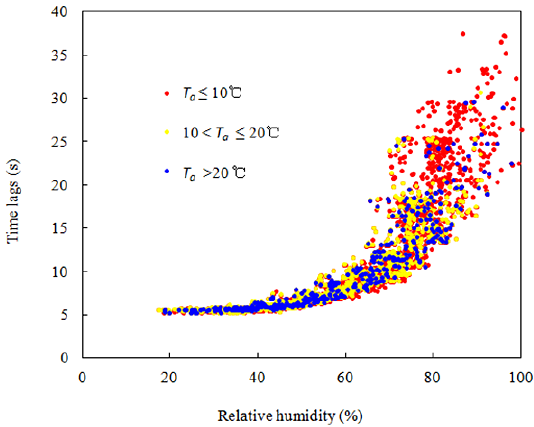
Figure 3. The actual tube delay for water vapor measurement in a 47m sampling tube of closed-path system. The time lags were calculated using the maximum cross-correlation method combining with the optimized time lag search windows presented in Table 2.